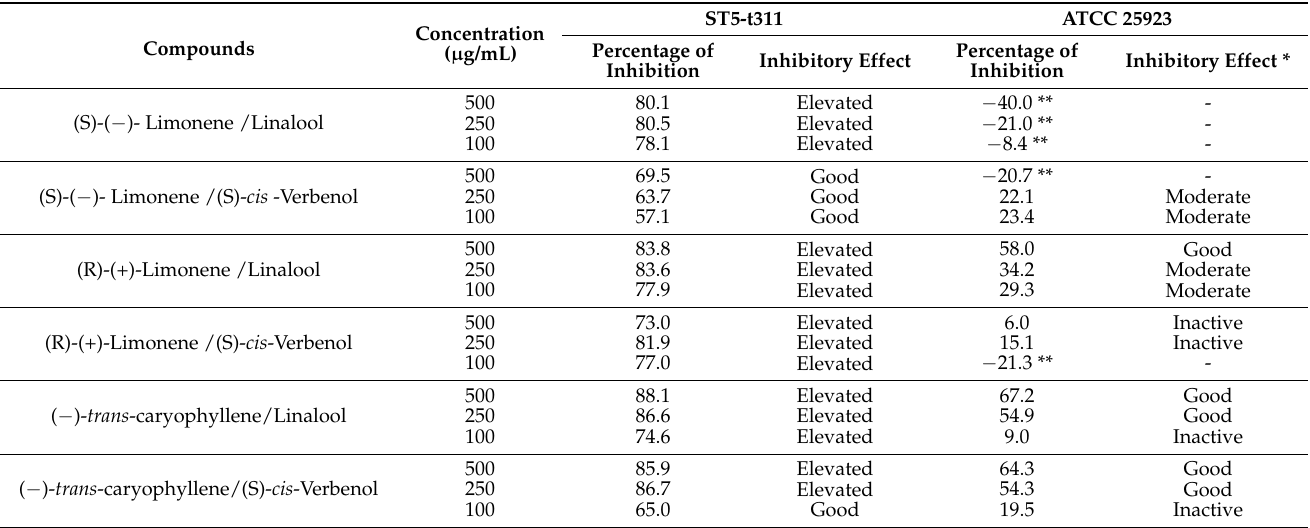
Table 3. Inhibition percentages of biofilm formed by S. aureus ST5-t311 isolated and ATCC 25923 using terpene